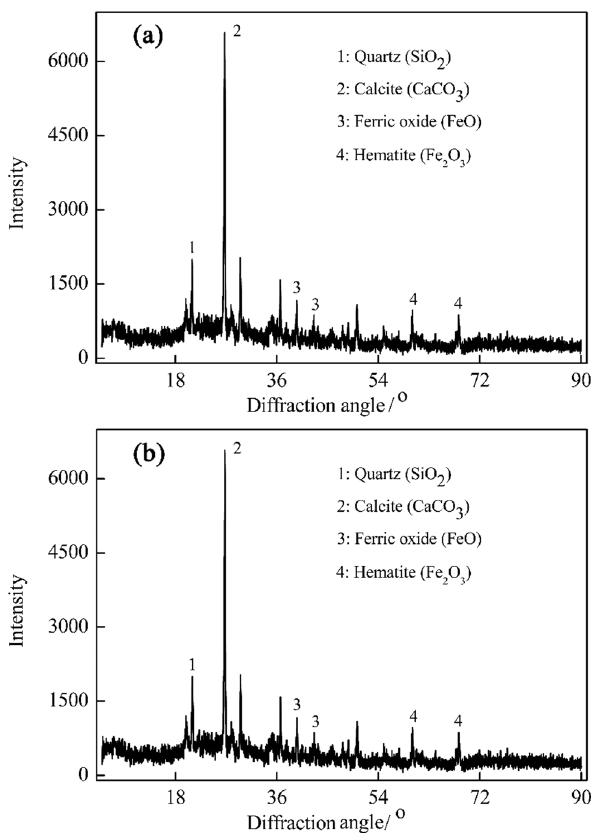
Figure 4: XRD spectra of green body ( a ) and porous ceramsite ( b )